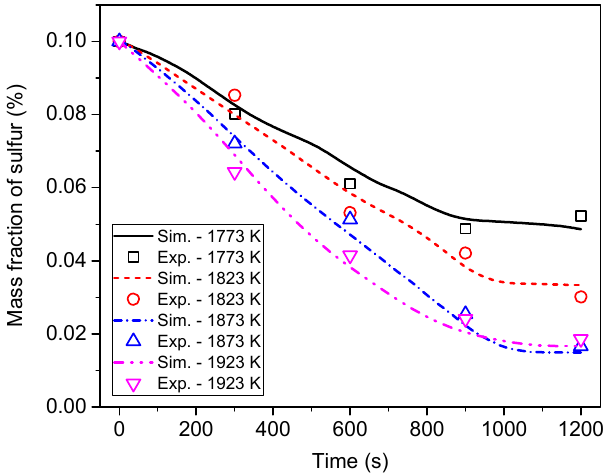
Figure 9. Variation of mass fraction of sulfur at point 2 in molten manganese over time.